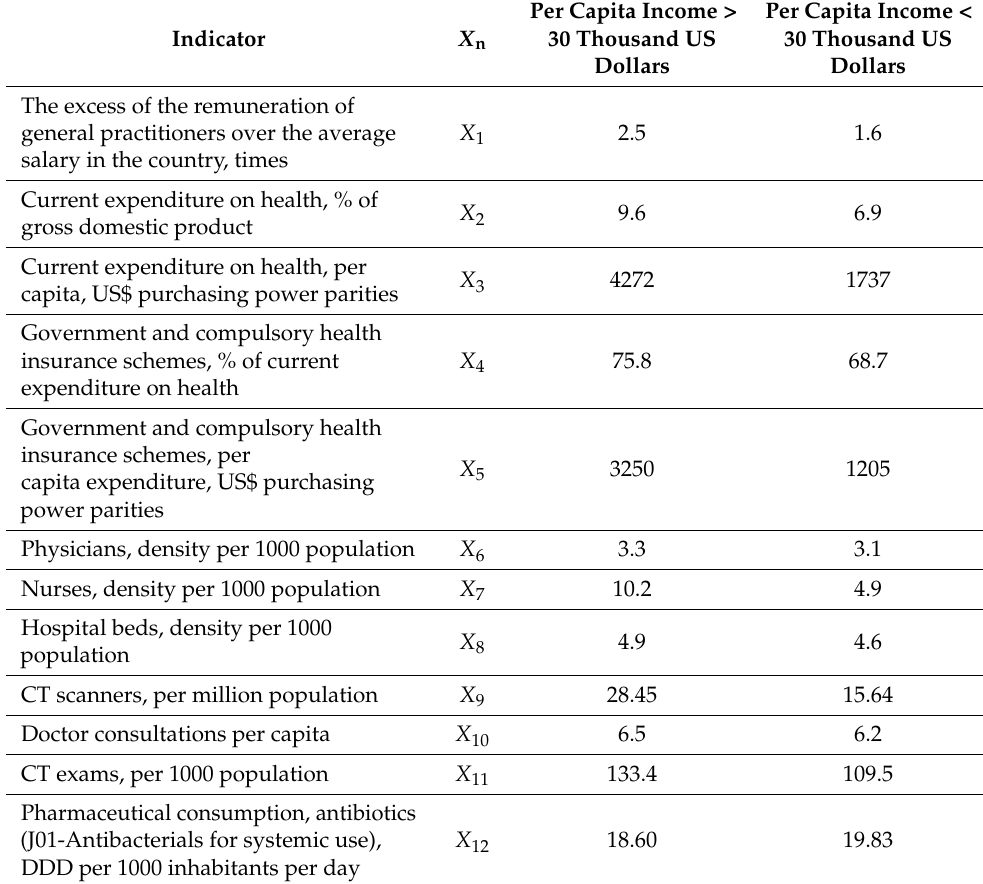
Table 1. Average values of indicators used in calculating the taxonomic development coefficient for two groups of OECDs countries for